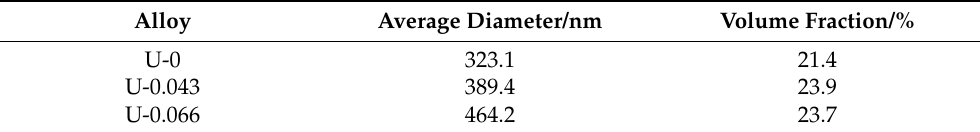
Table 6. The size and volume fraction of secondary γ (cid:48) in Sc-doped U720Li after heat treatment.